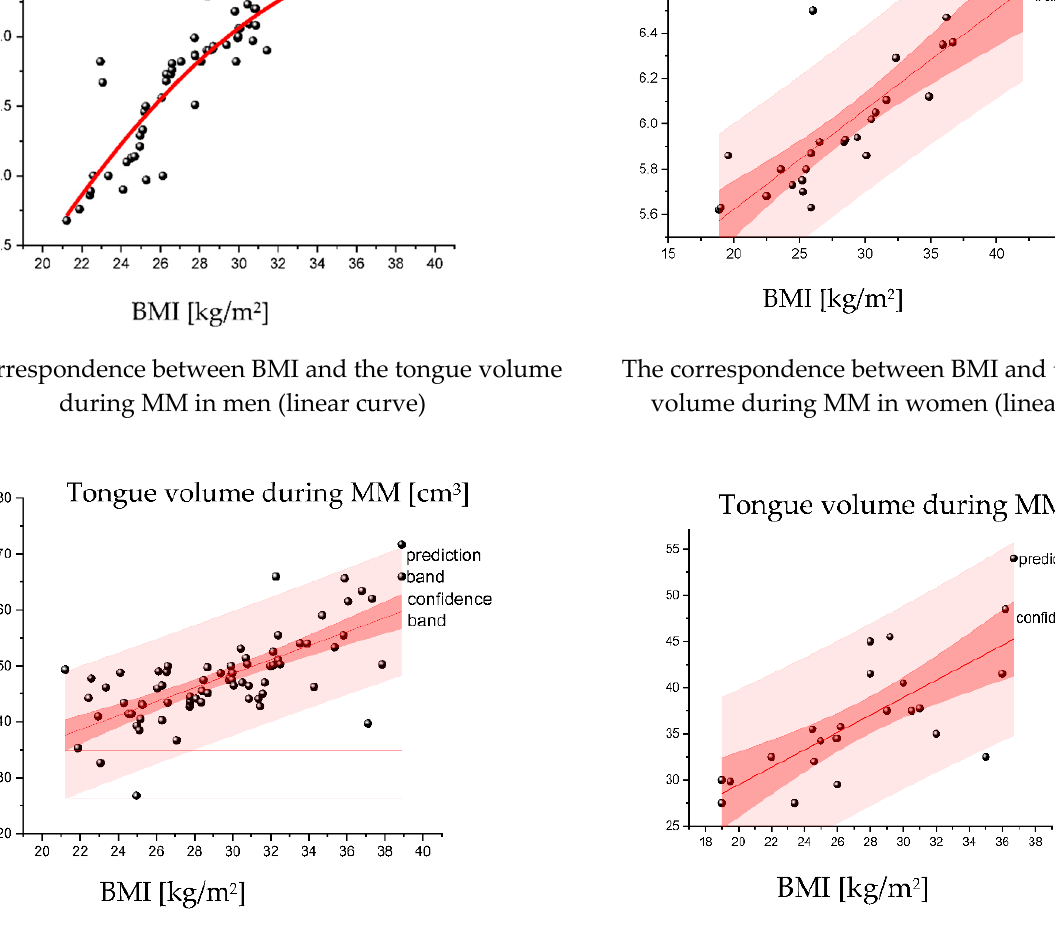
Figure 3. Correlation between BMI and the coronal diameter of the tongue using US and tongue volume during MM in male and female patients. Table 8. A prediction of tongue-based obstruction using tongue US parameters and anthropometric parameters by the quadratic discriminant